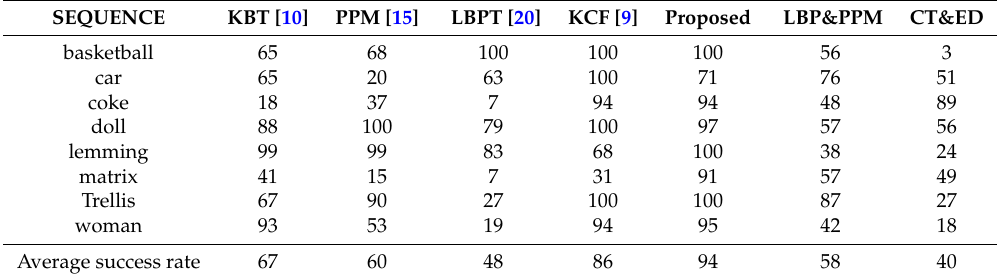
Table 4. Success rates (%) of the proposed method compared with the other trackers.